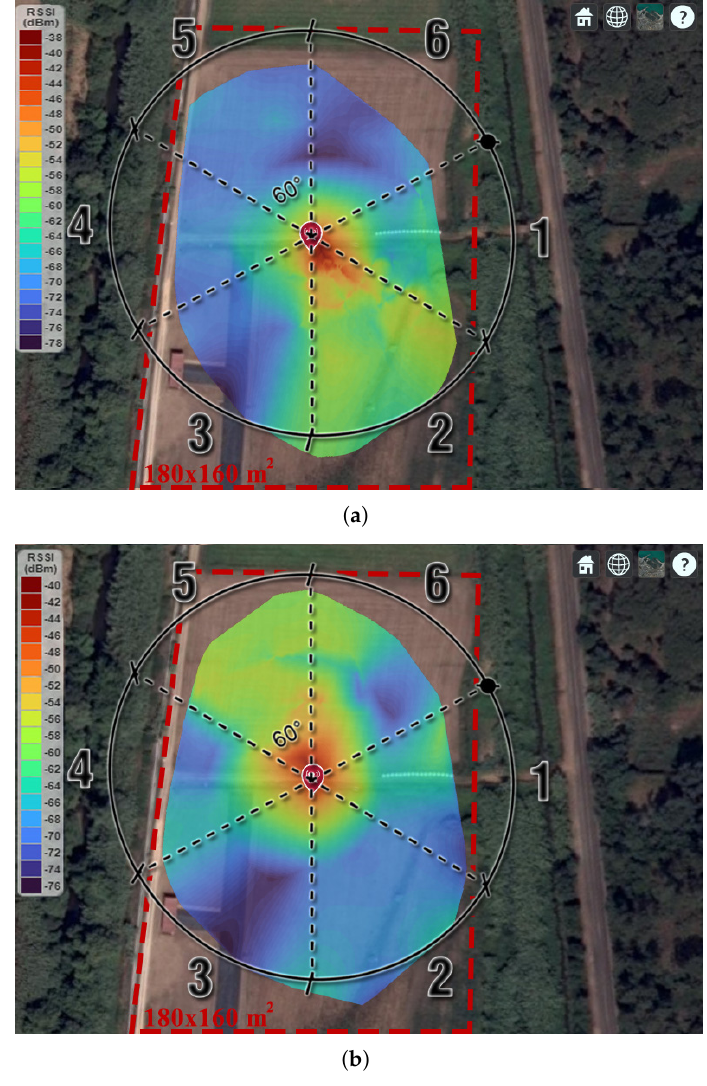
Figure 14. Field test results for the BS coverage campaign with: ( a ) Sector 2 and ( b ) Sector 5